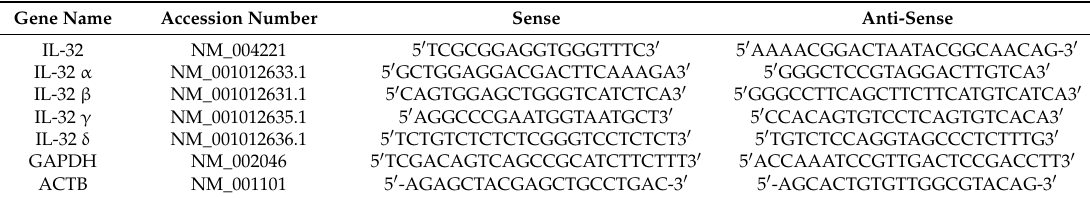
Table 1. Details of primers used in polymerase chain